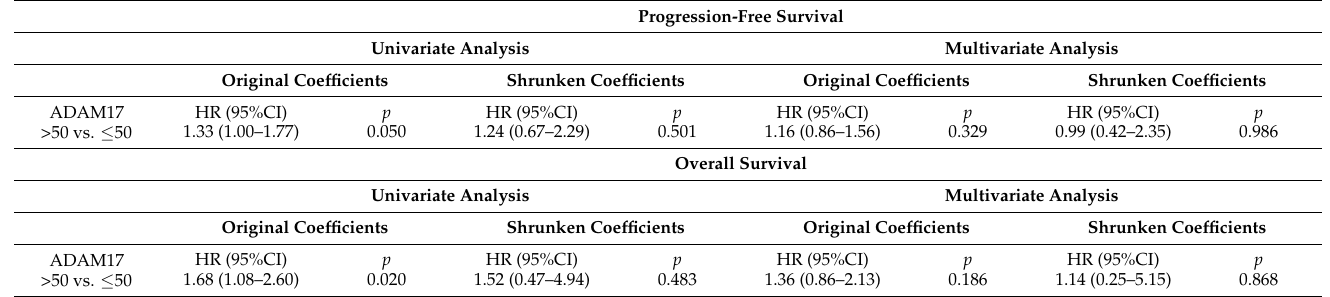
Table 3. Univariate and multivariate analysis for ADAM17 (categorized on best cut-off value) for PFS and OS. Original and shrunken coefficients are reported.